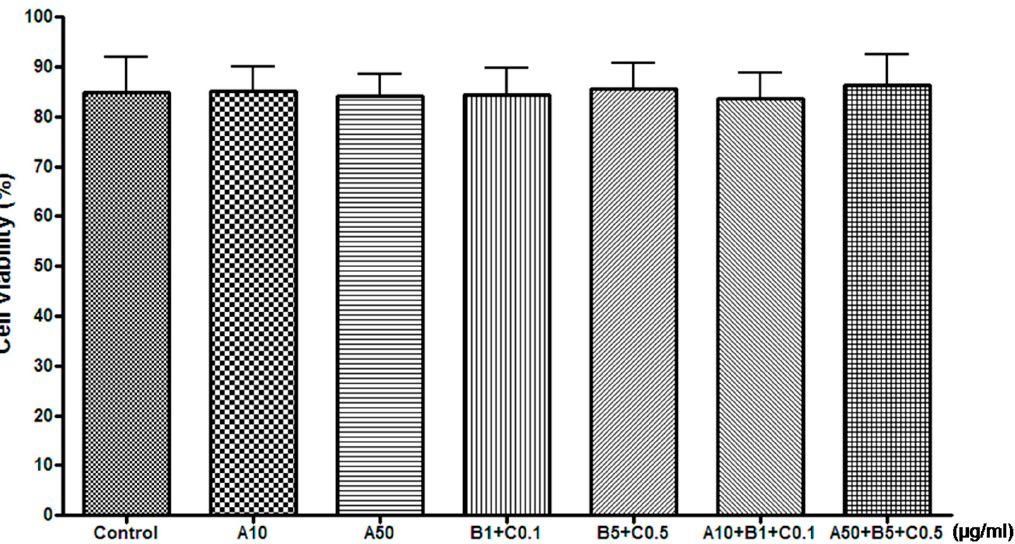
Figure 4. Effects of experimental drugs on SH-SY5Y cell viability by cell count experiment. ( μ g/mL, mean ± standard deviation, n = 5). No significant difference of cell viability was observed among groups. A, Chunghyuldan; B, ethanol extract of Radix Salviae Miltiorrhizae and Radix Notoginseng; C, Borneolum Syntheticum.